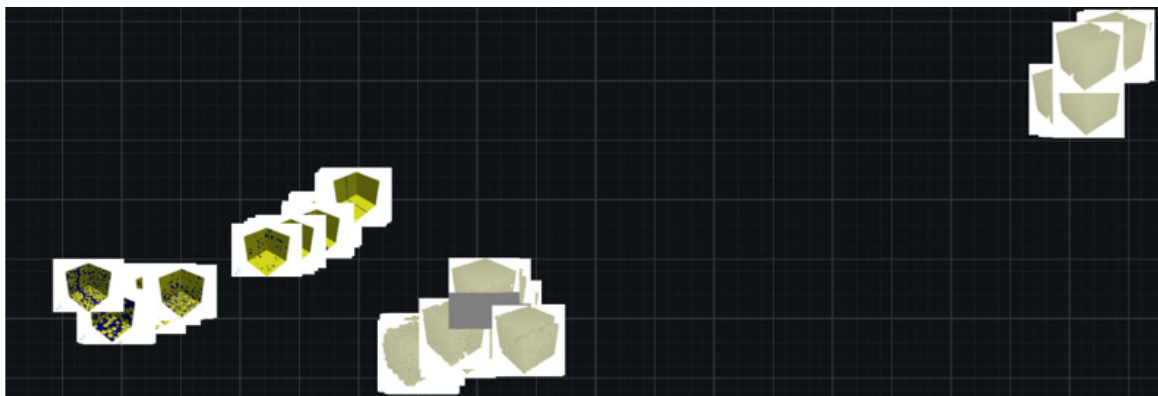
Figure 16. Anomaly score for some images.